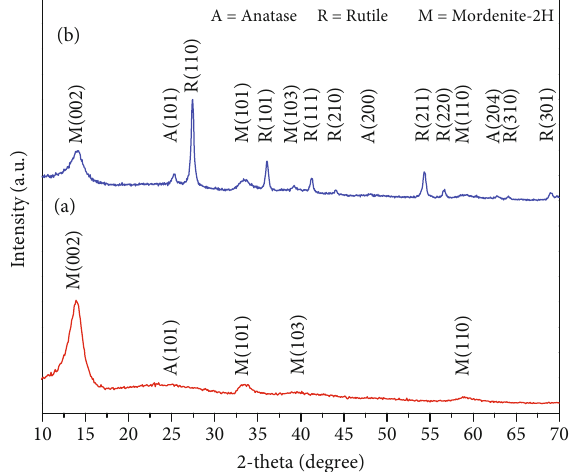
Figure 5: N adsorption isotherms for TiO 2 MoS . 2